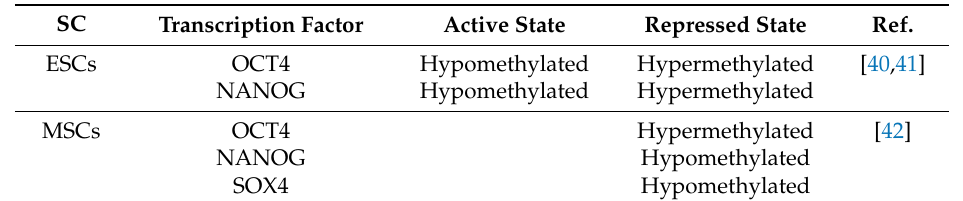
Table 2. DNA-methylation of transcription factors associated with pluripotency in embryonic stem cells (ESCs) and mesenchymal stem cells